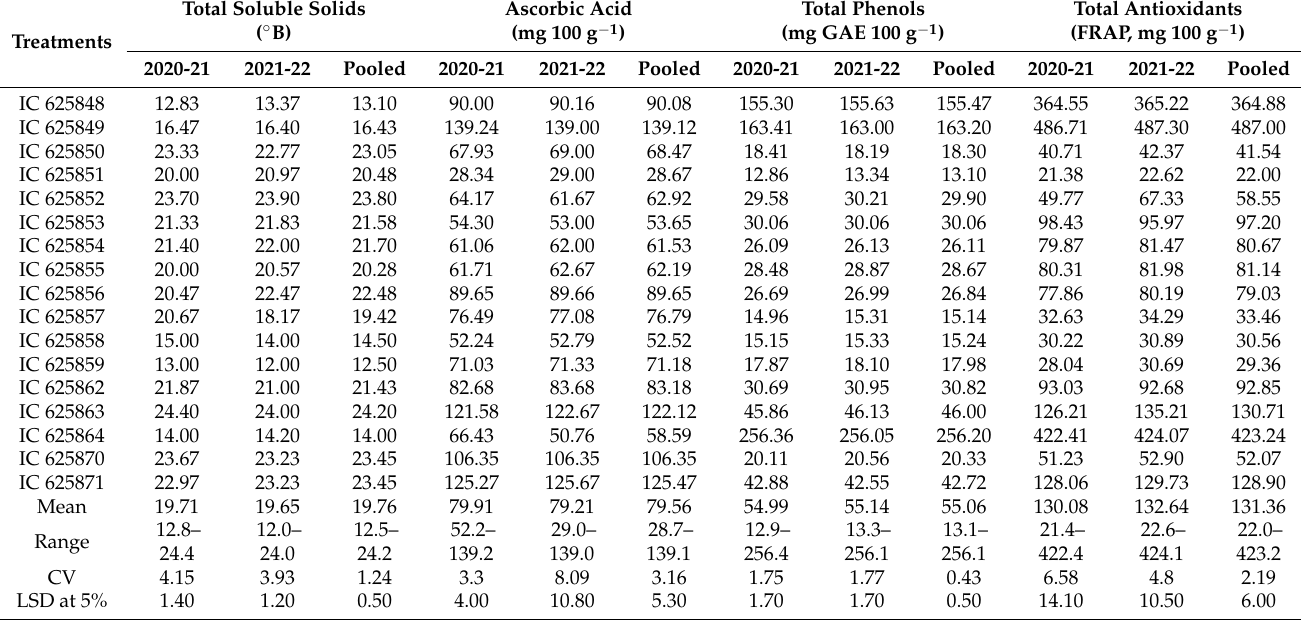
Table 3. Variations in mean values of physico-biochemical parameters (fresh weight basis) determined for the fruits of 18 genotypes of jujube for the period of 2020-21 and 2021-22 ( n =